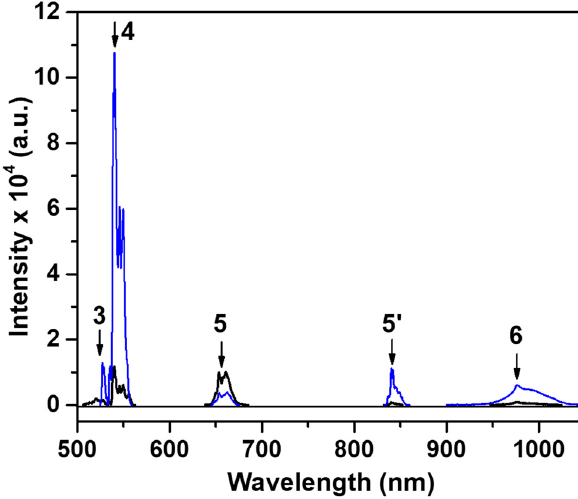
Figure 7: Di ff use re fl ectance spectra of the powder samples of down - conversion LE phosphors. Curve A corresponds to NaY F : 0.94 4 Figure 8: Visible and NIR photoluminescence spectrum of the phosphor powder NaY F : Yb Er 0.83 4 0.143 0.033 + + excited by 372 nm UV laser ( black curve ) and by 488 nm line of an Ar - ion laser ( blue ) . The peaks correspond to the absorption bands with the same numbers as in Figure 7. The new peak 5 ′ corresponds to the band at 850 nm. This band does not exhibit prominent absorption in Figure